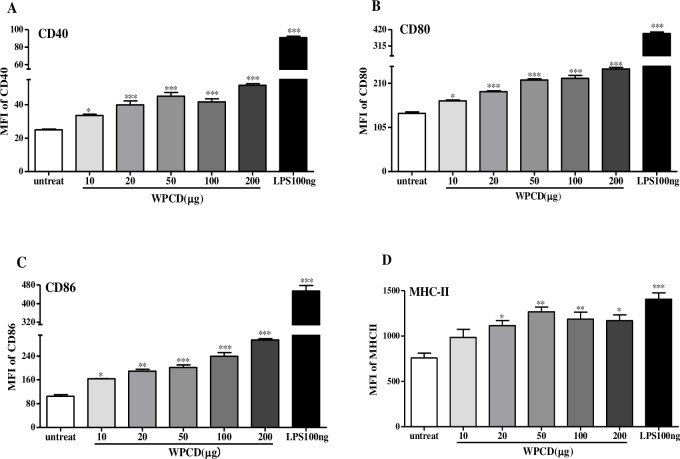
Effects of WPCD upon DCs phenotypic maturation in vitro.BM-DCs from C57BL/6 mice were treated with different concentrations of WPCD for 12 h. LPS was used as the positive control. Then, the expression levels of CD11c, CD40, CD80, CD86, and MHC-II in cells were analyzed. Phenotypic maturation of BM-DCs was induced by PBS, LPS and WPCD. The mean fluorescence intensity values (MFI) of CD40 (A), CD80 (B), CD86 (C), and MHC-II (D) were shown. Data represent mean ± SD (n = 3) from 3 independent experiments. *P < 0.05, ** P < 0.01, *** P < 0.001 compared with the untreated DCs group.